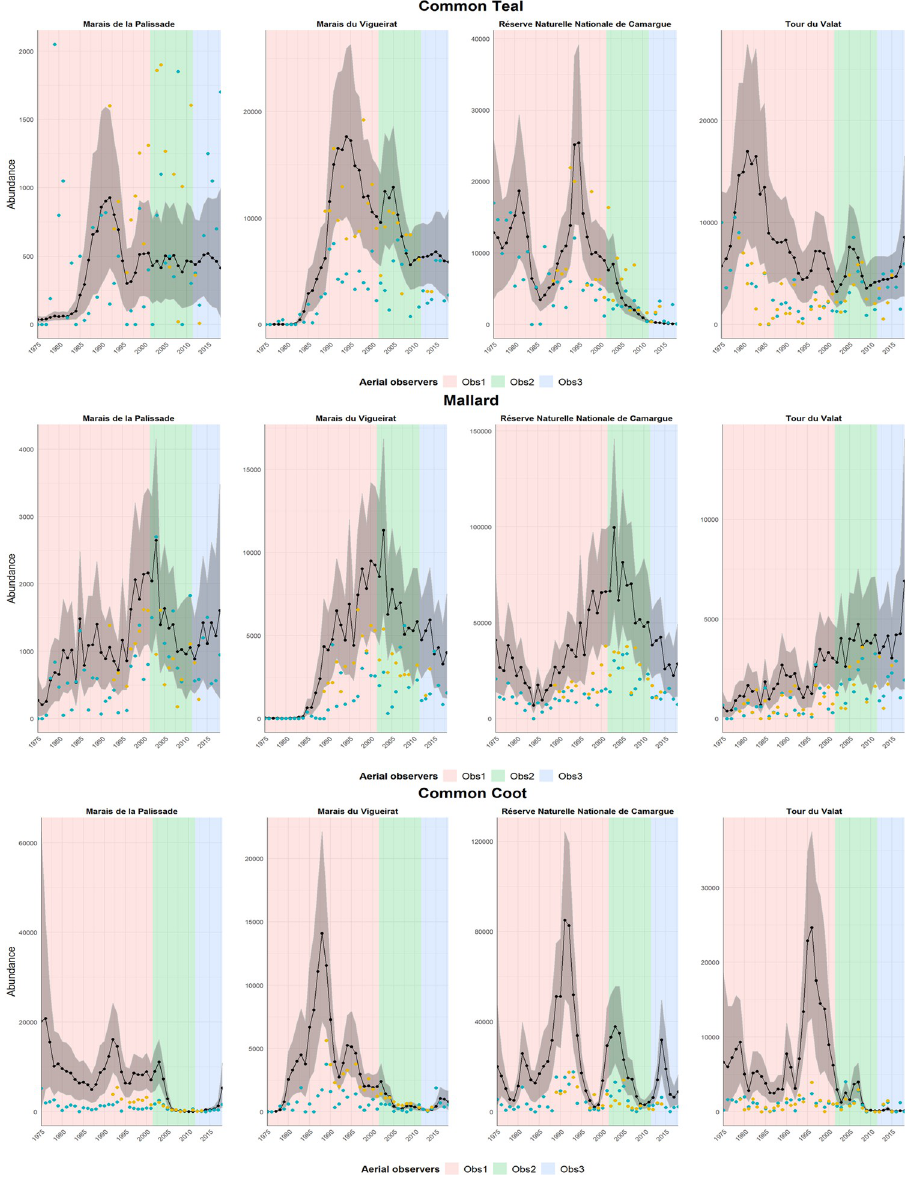
Fig 3. Estimation of the abundance index (black curve with its 95% credible intervals) over the entire monitoring period for the month of January and for each of the protected areas. Aerial counts are represented by blue dots. Ground counts are represented by yellow